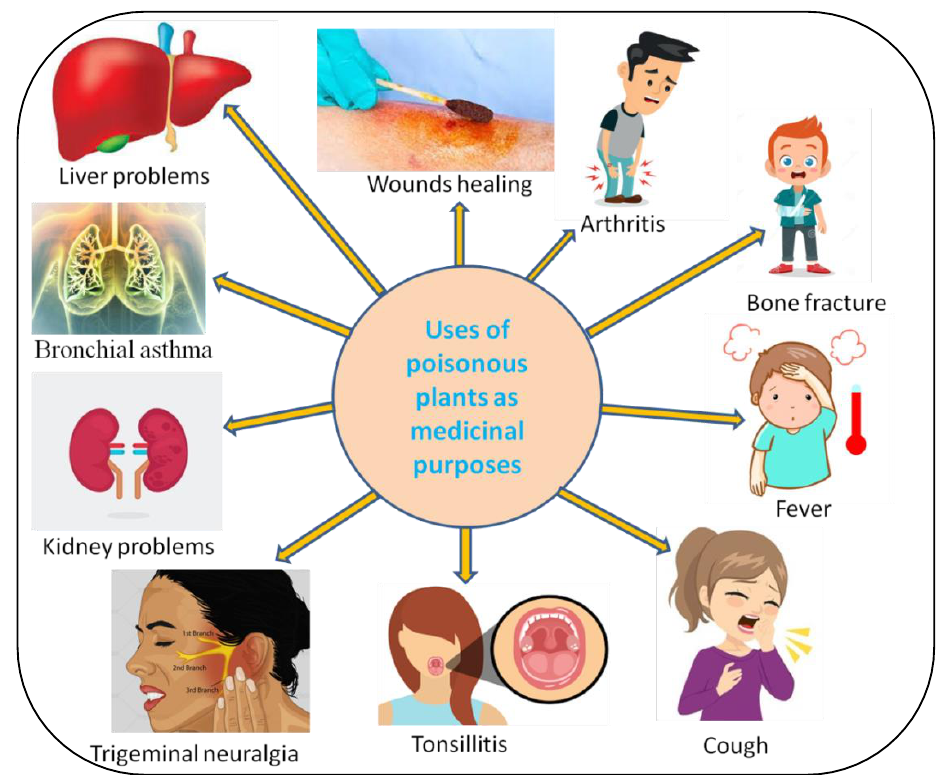
Figure 4. Uses of poisonous plants to cure several